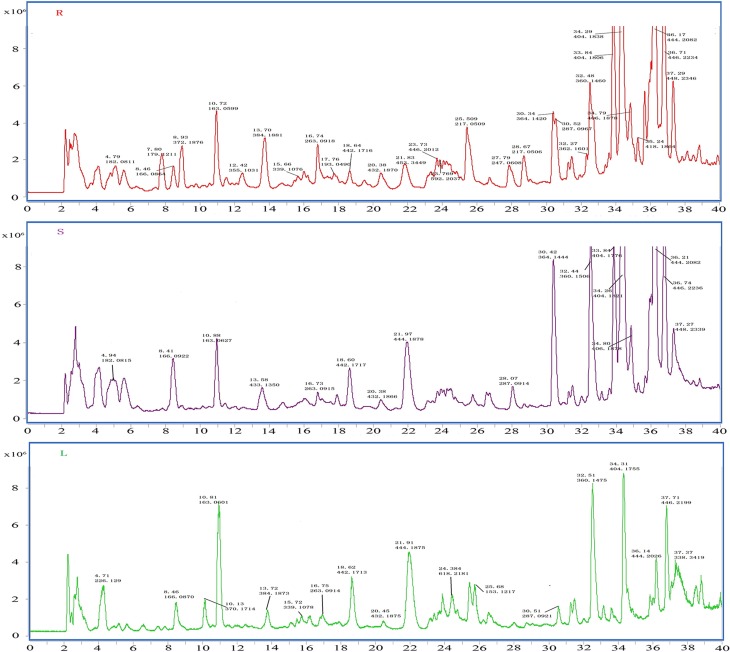
MS TIC chromatograms of roots (R), stems (S), and leaves (L) of P. praeruptorum by HPLC/Q-TOF MS in positive ion mode. Peak is marked by retention time and measured molecular weight.